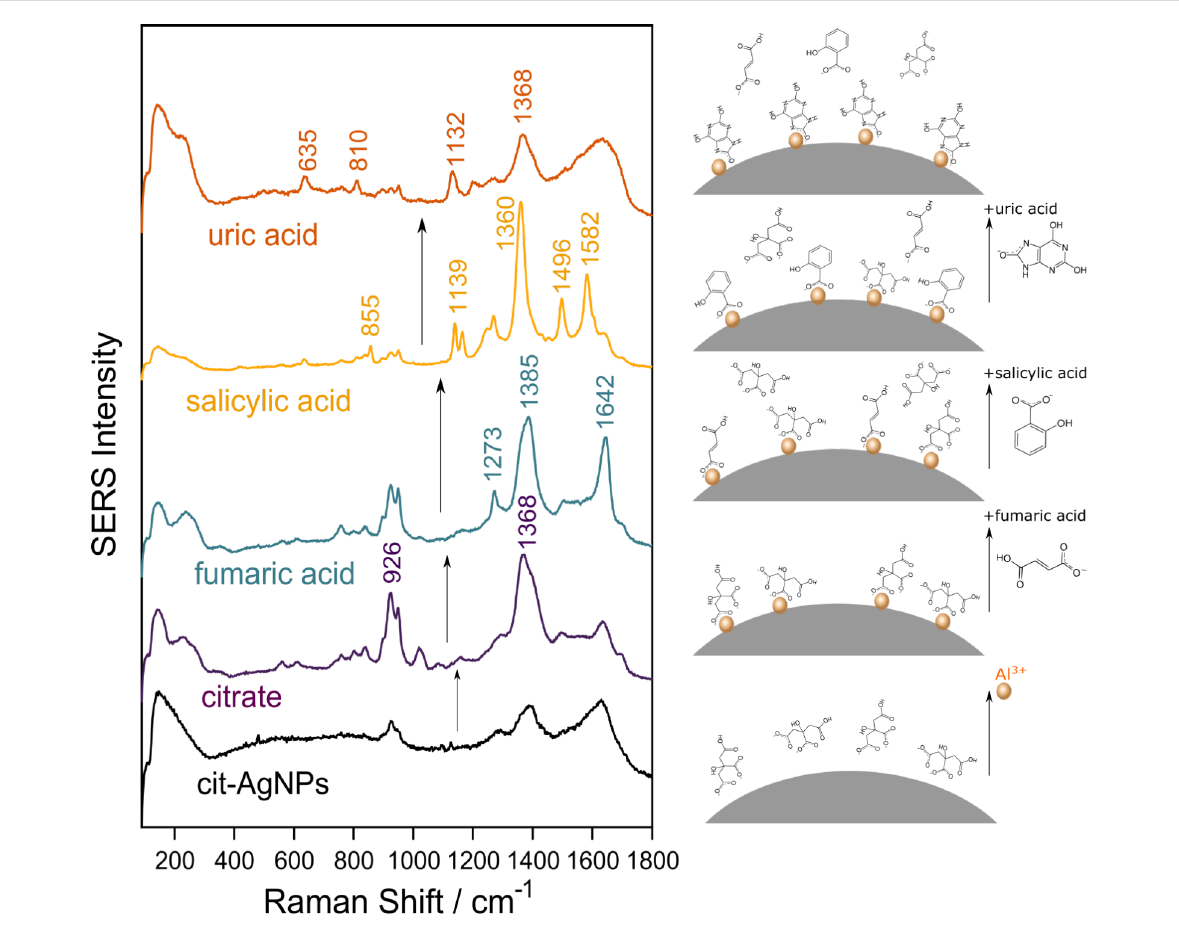
Figure 3: From bottom to top: SERS spectrum of the cit-AgNPs as synthesized, SERS spectrum of citrate after activation of the colloids with 50 µM Al 3+ , SERS spectra of the same solution with fumaric acid, salicylic acid and uric acid added subsequently. The SERS spectra were recorded by aver- aging four acquisitions of 10 s exposure each and were normalized to unity.